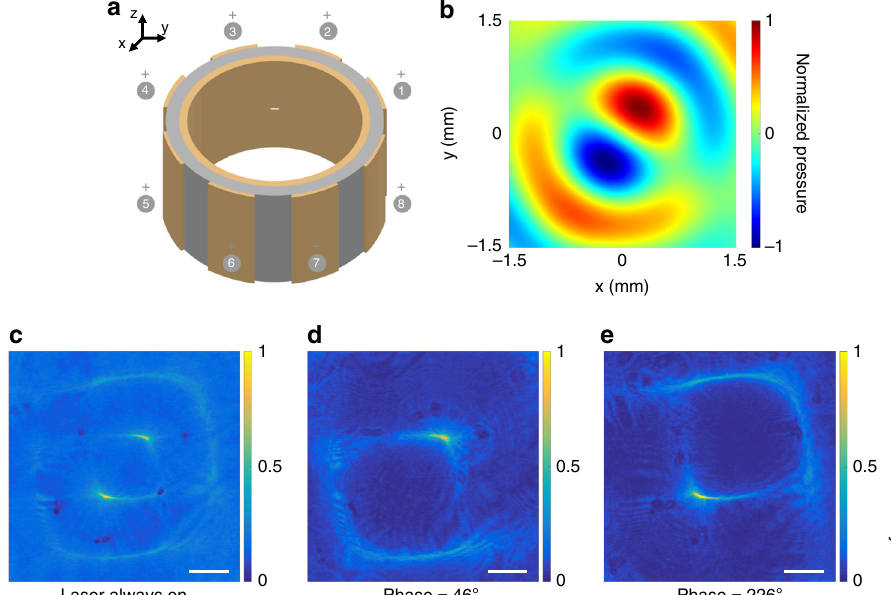
Fig. 5 Multi-segment transducer array generates complex light patterns. a A multi-segment cylindrical transducer array. Each segment is a cylindrical section with a height of h = 30 mm. b Simulation of the ultrasonic pressure dipole mode obtained within a cylindrical phased array, where opposite phase voltages are applied to sections 1, 2, 3 and 5, 6, 7. The optical image experimentally captured when: c the laser is continuously on (no modulation), d the laser is pulsed and synchronized with the ultrasonic transducer at 46° phase, and e the laser is synchronized with the ultrasonic transducer at 226° phase. The intensity of each 2D cross-section is normalized to its maximum value and the scale bar is 500 μ